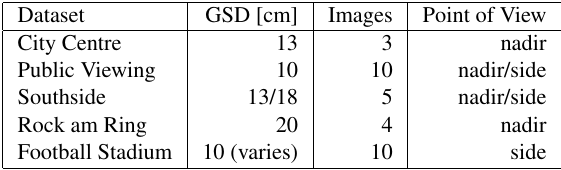
Table 1: Overview of the five different data